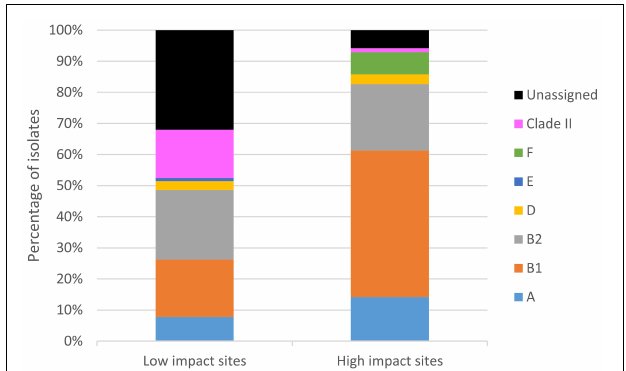
FIGURE 5 | Distribution of E. coli phylogroups and clade II isolates in the TK watershed. An E. coli ST was assigned into one of the eight phylogroups according to information in Clermont et al. (2015, 2019) and EnteroBase (Alikhan et al., 2018). When information is not readily available, phylogroup was inferred for an ST by its genetic relatedness with STs of known phylogroup: two STs were assumed to belong to the same phylogroup only if they are SLVs or double locus variants (DLVs). No assignment was made if criteria were not met.